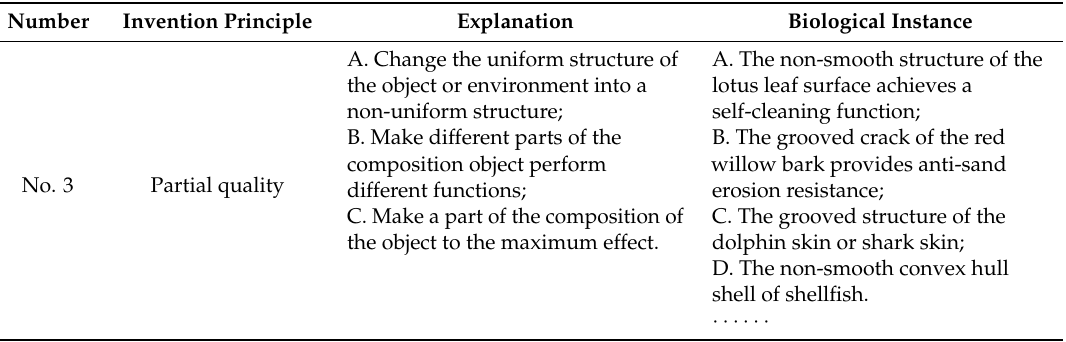
Table 2. Partial biological instance library corresponding to the principle of local quality in invention